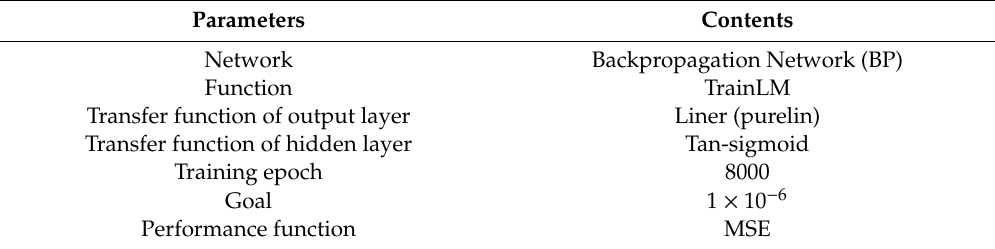
Figure 8. Schematic illustration of the artificial neural network (ANN) architecture of the used network. Table 2. Settings of the training parameters for the used neural